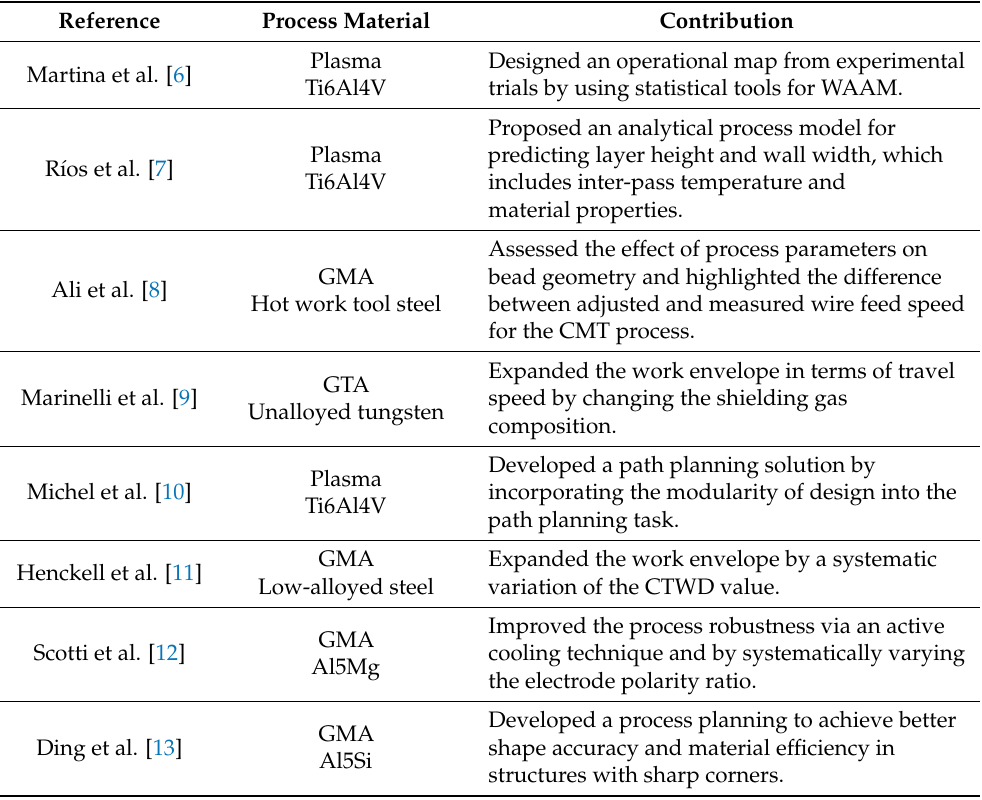
Table 1. Collection of contributions on parametric charts and approaches for their expansion and robustness improvement in